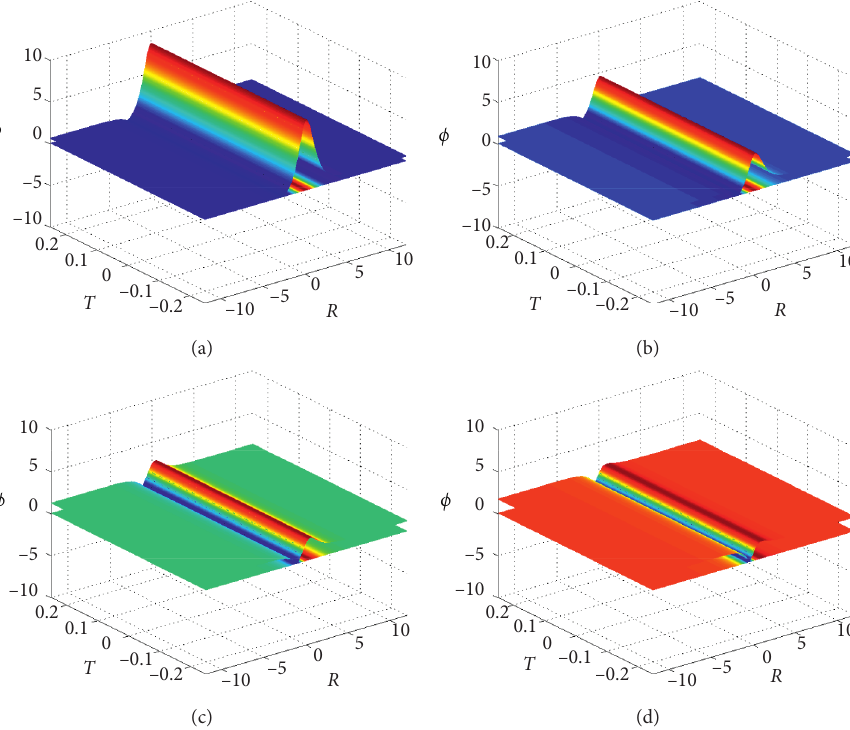
Figure 2: The values of the parameters are as follows. (a) β � 1 . 2, β � 1 . 8, ω � 1, and ϖ � 1. (d) β (c) β 1 3